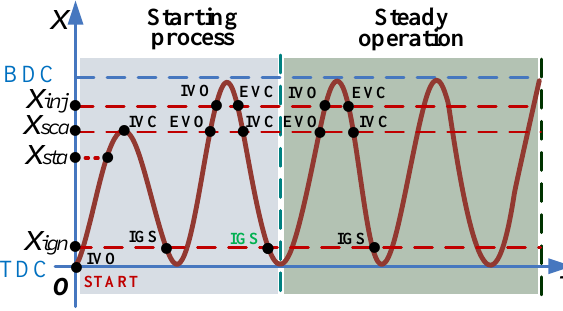
Figure 8. Starting process and steady operation illustration.